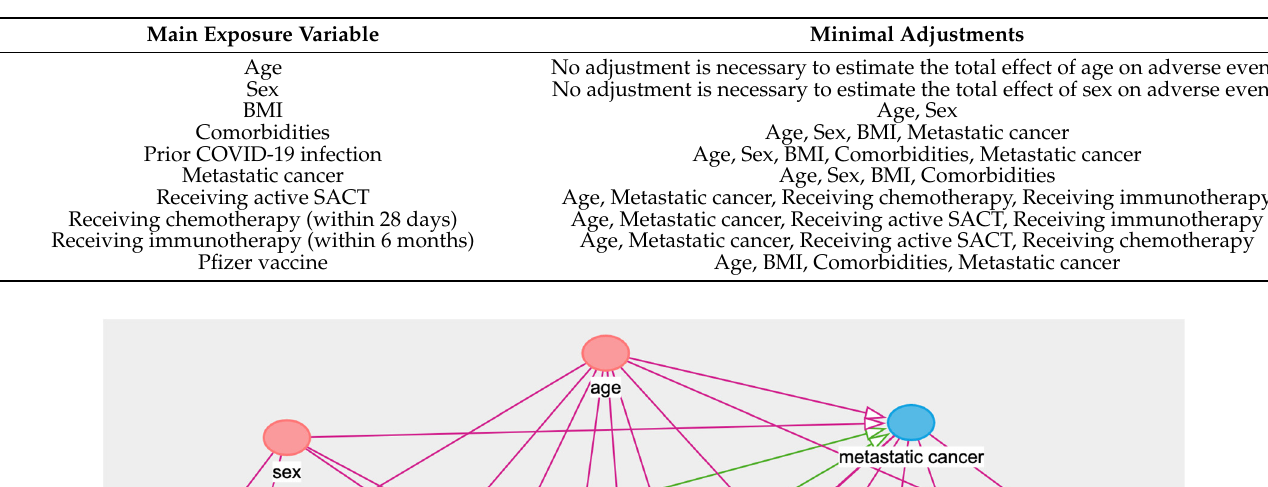
Table A1. Overview of minimal adjustments for the associations between patient and oncological characteristics and risk of developing COVID-19 vaccine-related adverse events (www.dagitty.net, accessed on 17 May 2021). SACT, systemic anti-cancer therapy.